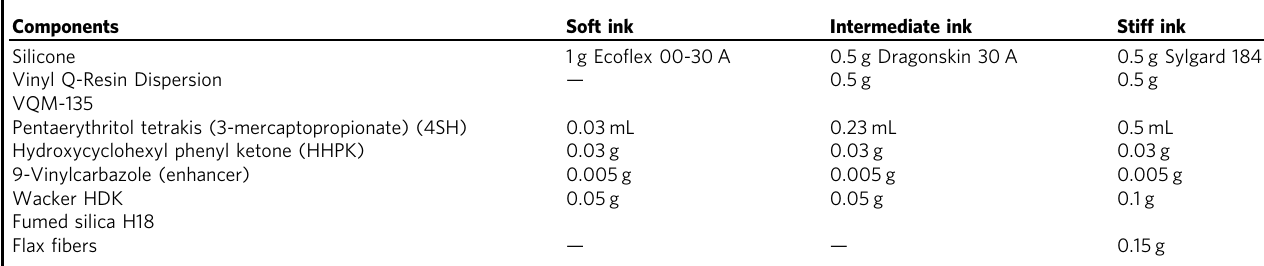
Table 1 Formulations for the soft, intermediate, and stiff Silinks Components